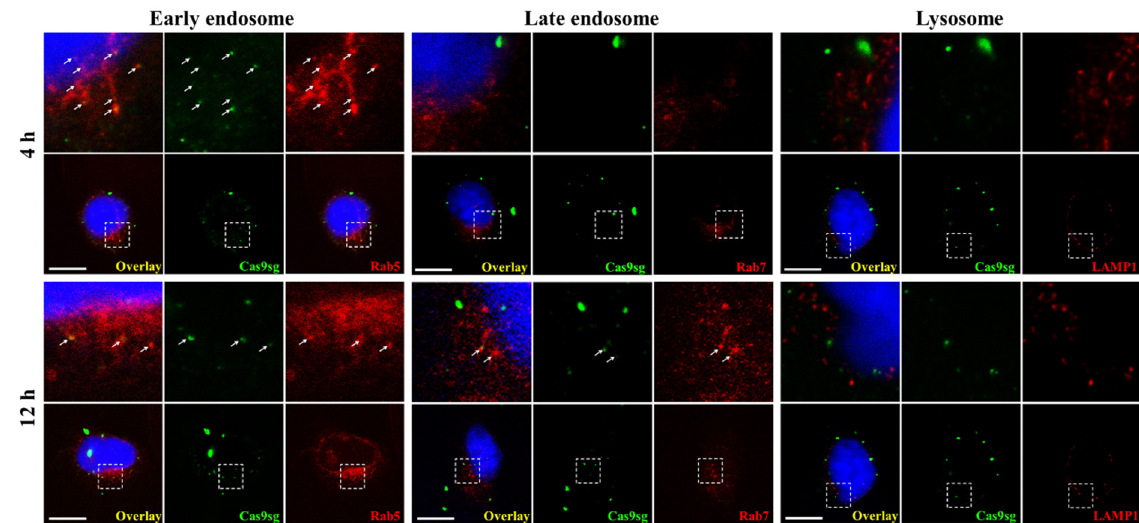
Figure 5. Confocal immunofluorescence images of co-localization of Cas9sg (green) with early endosomal marker Rab5 (red), late endosomal marker Rab7 (red) and lysosomal marker LAMP1 (red) (C Cas9sg = 8 nmol L − 1 ).